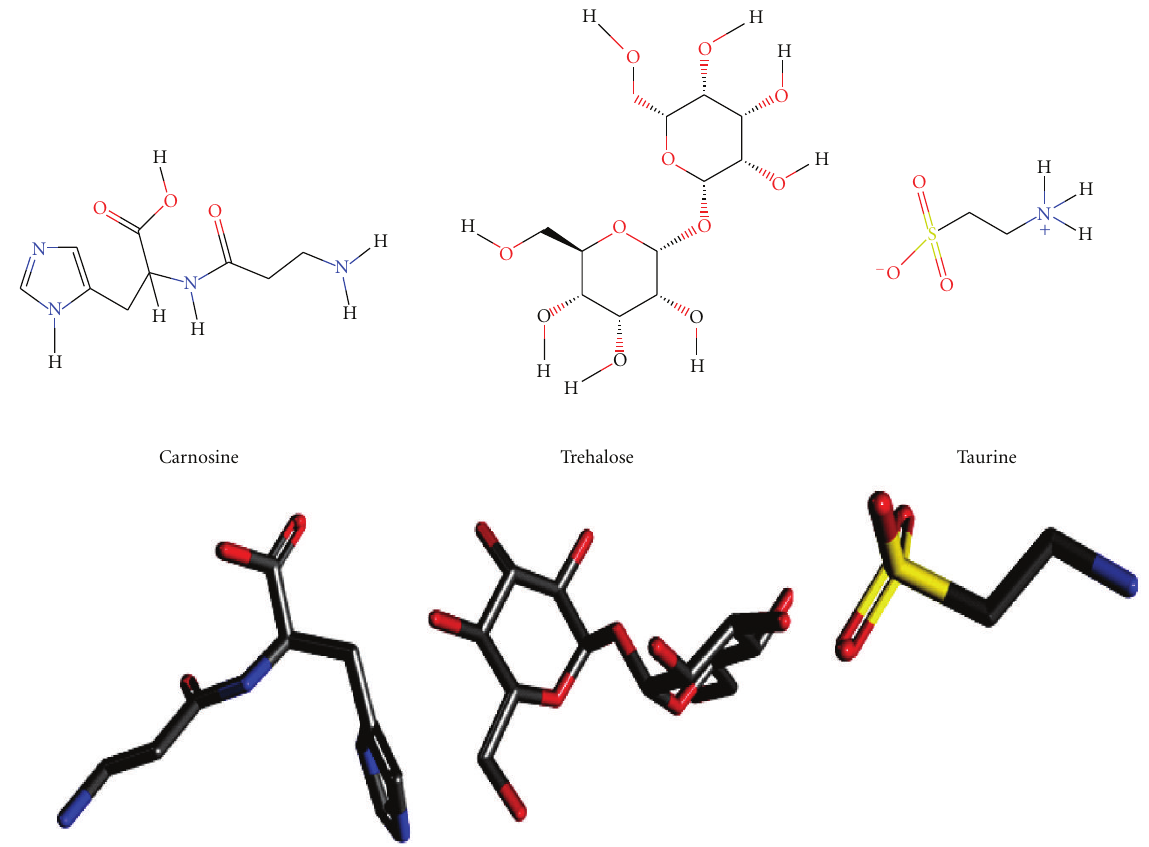
Figure 2: Chemical structure of selected osmolytes. Upper panel: structure in 2D; lower panel, structure in 3D configurations,